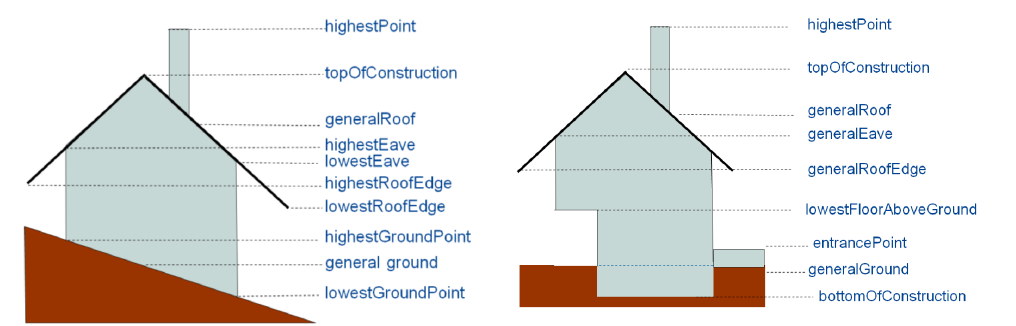
Figure 5. Examples of elevation references for different kinds of building